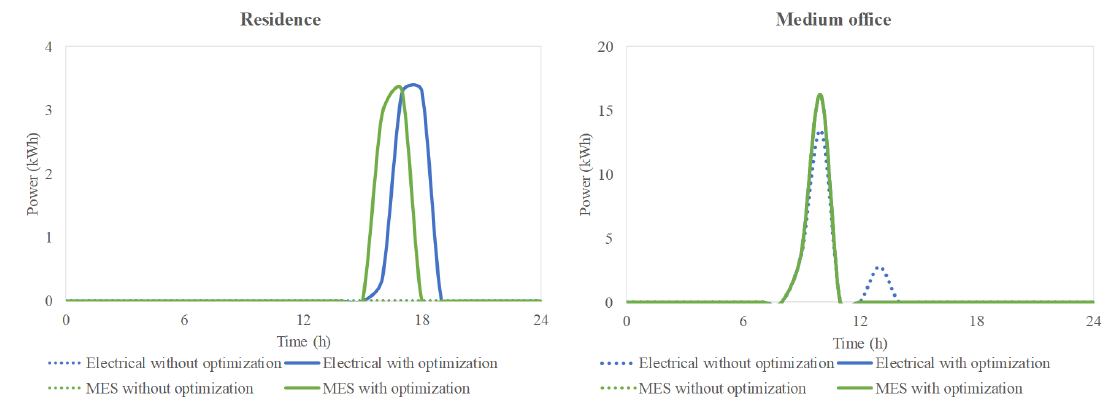
Figure 19. EVs discharging power in a medium size office.